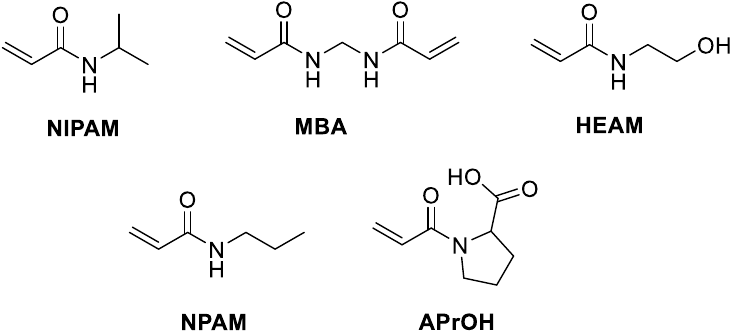
Figure 1. Monomers and crosslinkers used in the preparation of nanogels.